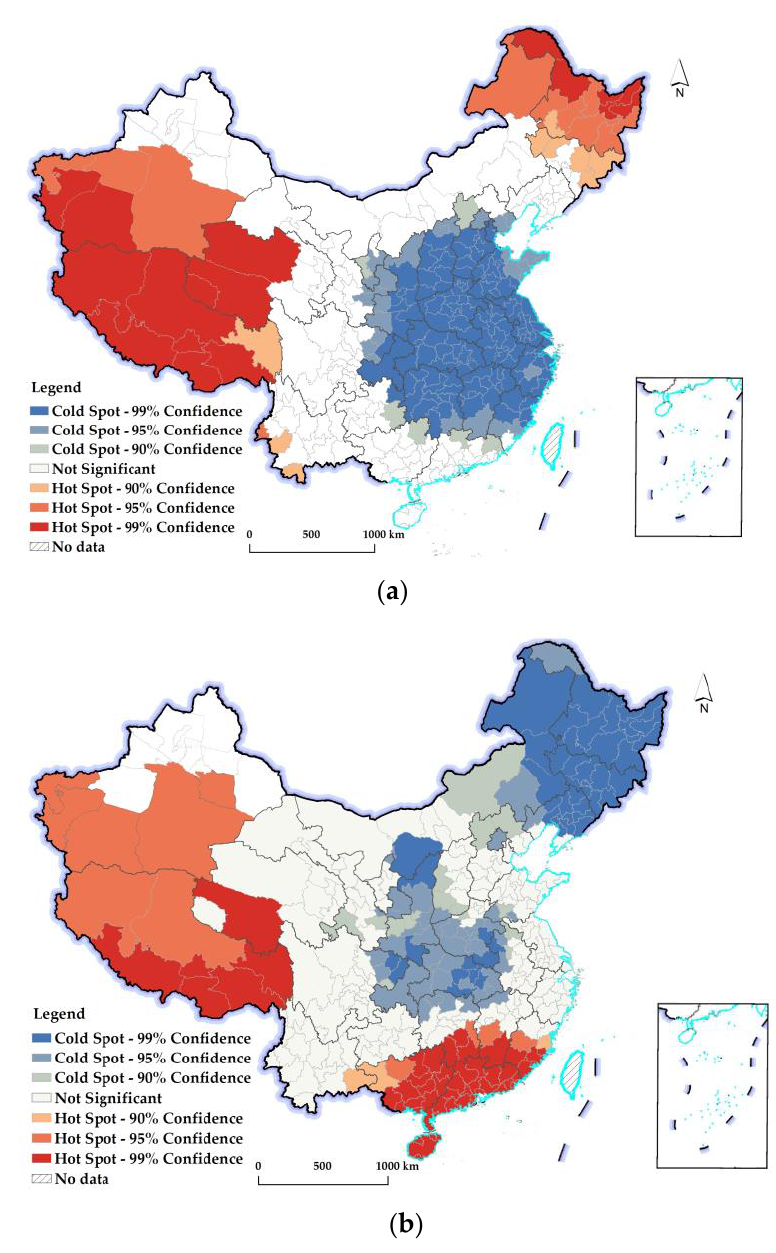
Figure 6. The hot spots of change in rural population density from 2000 to 2020. ( a ) 2000 – 2010; ( b )